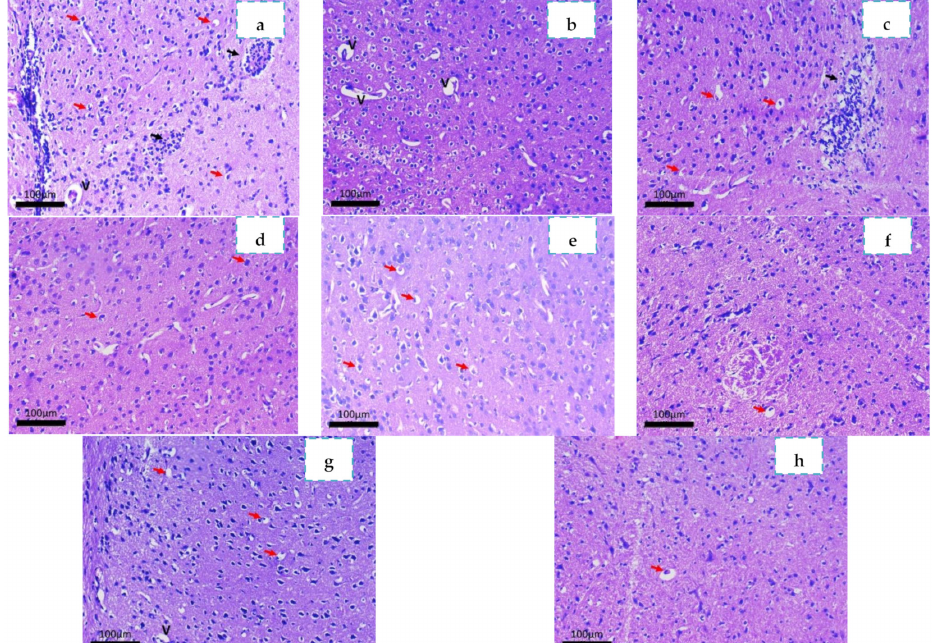
Figure 11. Brain section of different Toxoplasma-infected models: ( a ) Subgroup Ia: Reveals multiple foci of neuronal degenerative change (red arrows) and gliotic nodules (black arrow). Peri vascular edema was seen (V). ( b ) Subgroup Ib: Marked improvement was noted. Only few degenerated neurons were seen (red arrows) but perivascular edema is still seen (V). ( c ) Subgroup IIa: No improvement was detected. Multiple foci of neuronal degenerative change were still noted (red arrows) and gliotic nodule (black arrow). ( d ) Subgroup IIb: Marked improvement was noted. Only few degenerated neurons were seen (red arrows). ( e ) Subgroup IIc: Moderate improvement was noted. Some degenerated neurons were seen (red arrows). ( f ) Subgroup IId: Marked improvement was noted. Only few degenerated neurons were seen (red arrows). ( g ) Subgroup IIe: Moderate improvement was noted. Some degenerated neurons were seen (red arrows). Focal perivascular edema is seen (V). ( h ) Subgroup IIf: Marked improvement was noted. Only few degenerated neurons were seen (red arrows) (H&E,